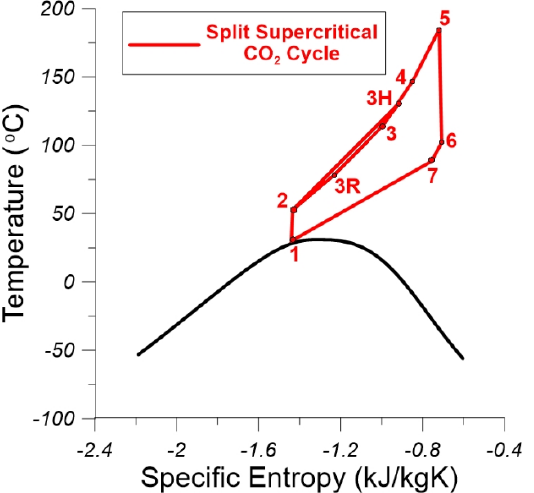
Figure 5. Representation of the split supercritical CO 2 cycle at temperature – entropy (T-s).